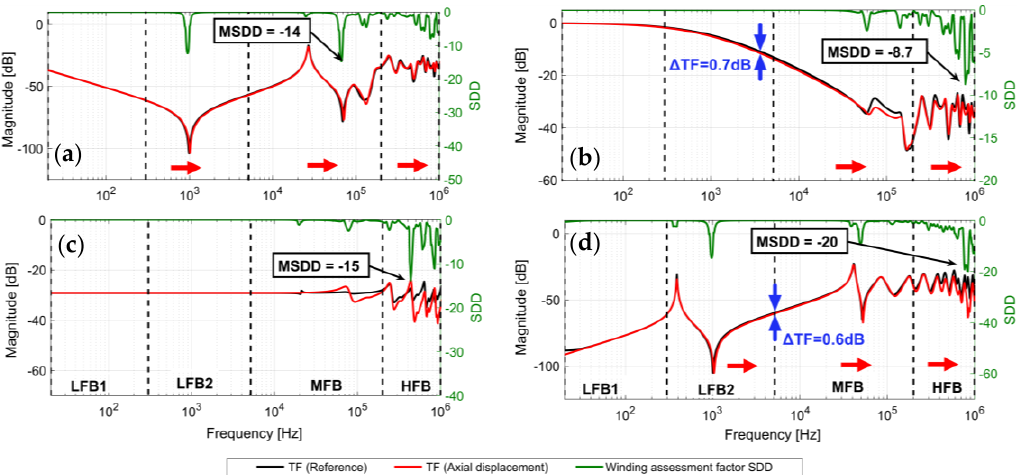
Figure 16. TFs of healthy and axially displaced B-phase winding (vector group YNyn0), and SDD as a measure of deviation between TFs; ( a ) HV-OC ( b ) HV-SC ( c ) IIW ( d ) CIW.